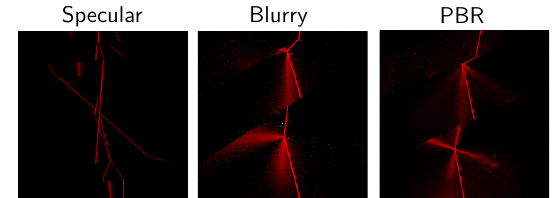
Figure 11: Types of reflection in test sets. The three test sets consist of sharp specular reflec- tions, blurry reflections, and a variety of re- flections produced by PBR